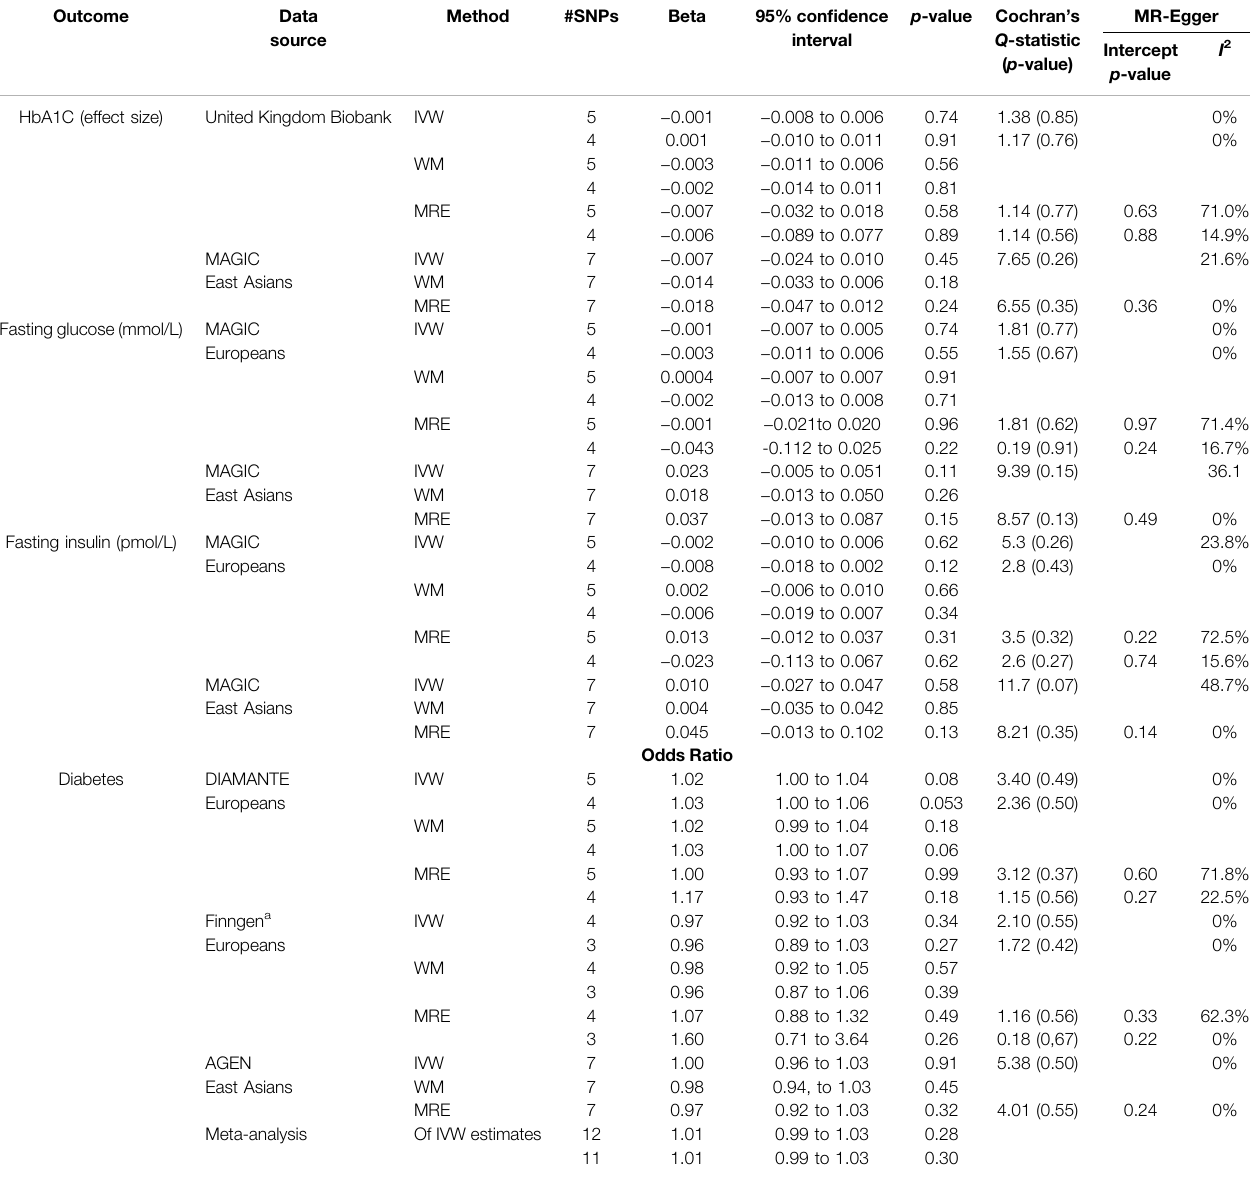
TABLE 2 | Mendelian randomization estimates for liability to periodontitis on HbA1C, fasting glucose and fasting insulin, and T2DM using all fi ve or four SNPs to predict periodontitis obtained from Europeans for the MR estimates in Europeans and seven SNPs to predict periodontitis in East Asians for the MR estimates in East Asians.